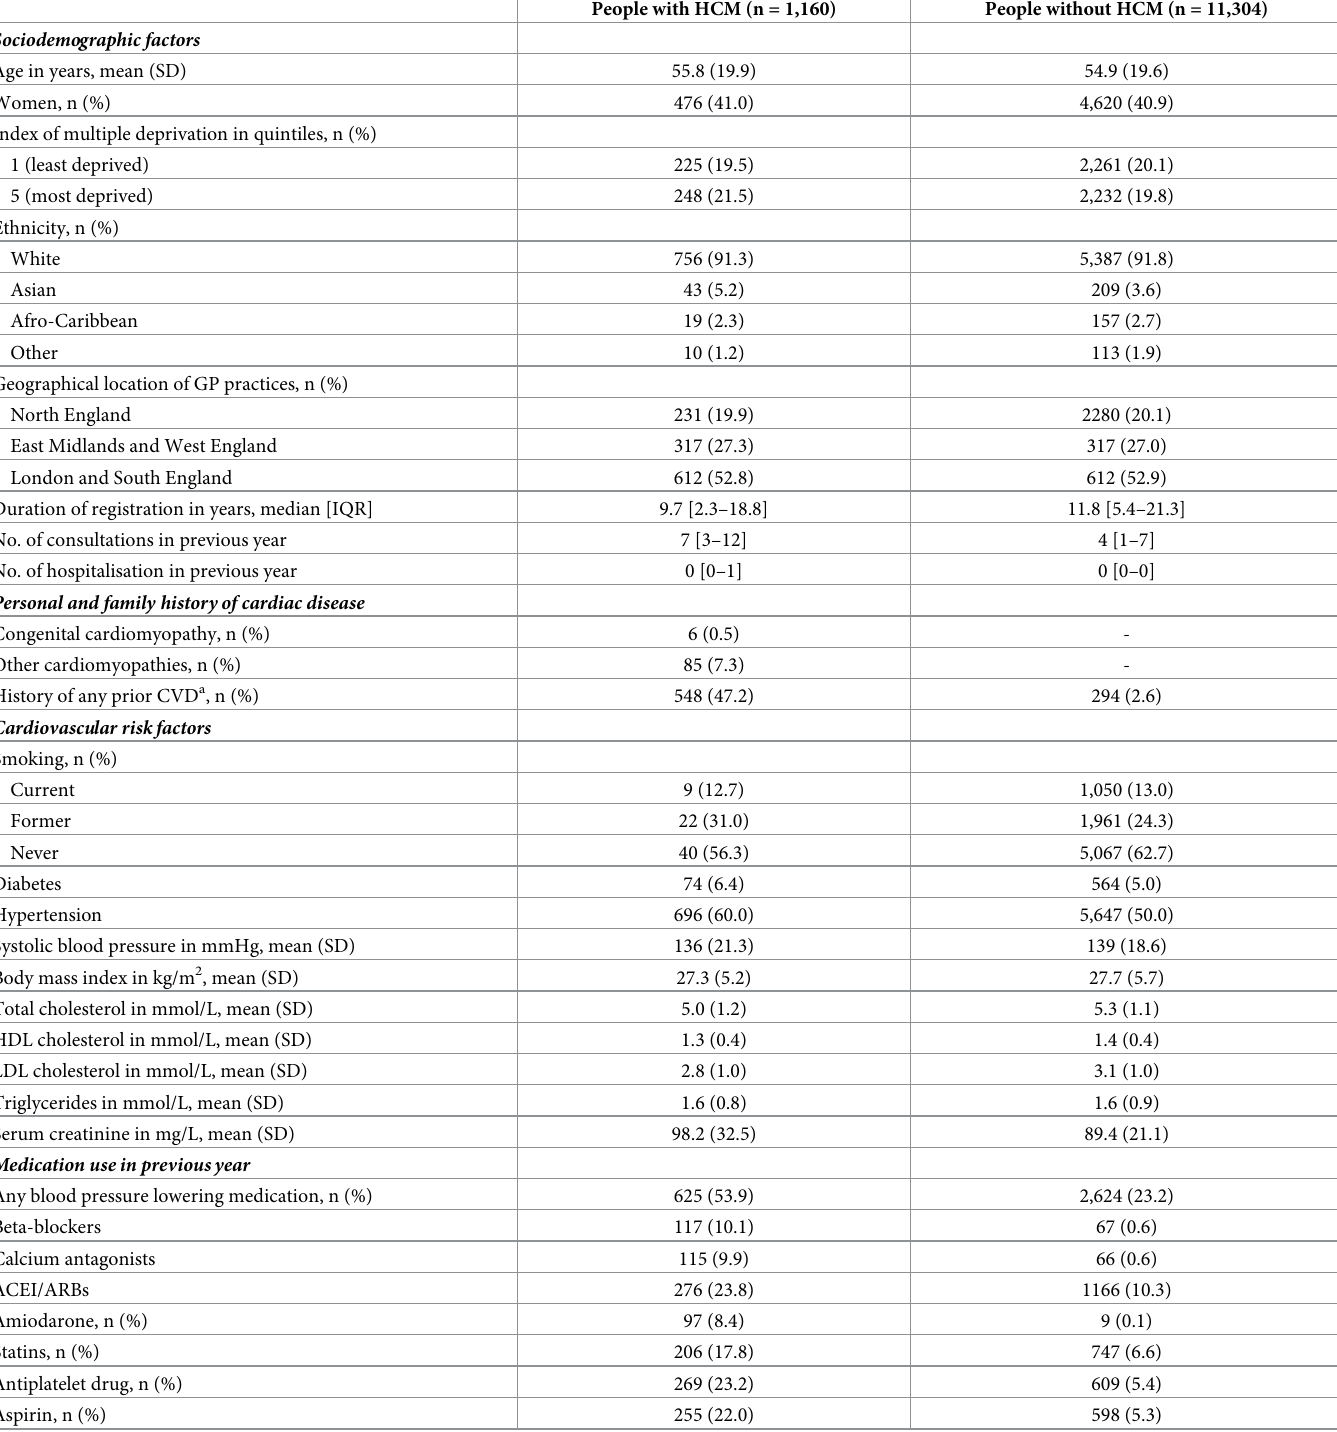
Table 1. Characteristics of a national sample of people with and without hypertrophic